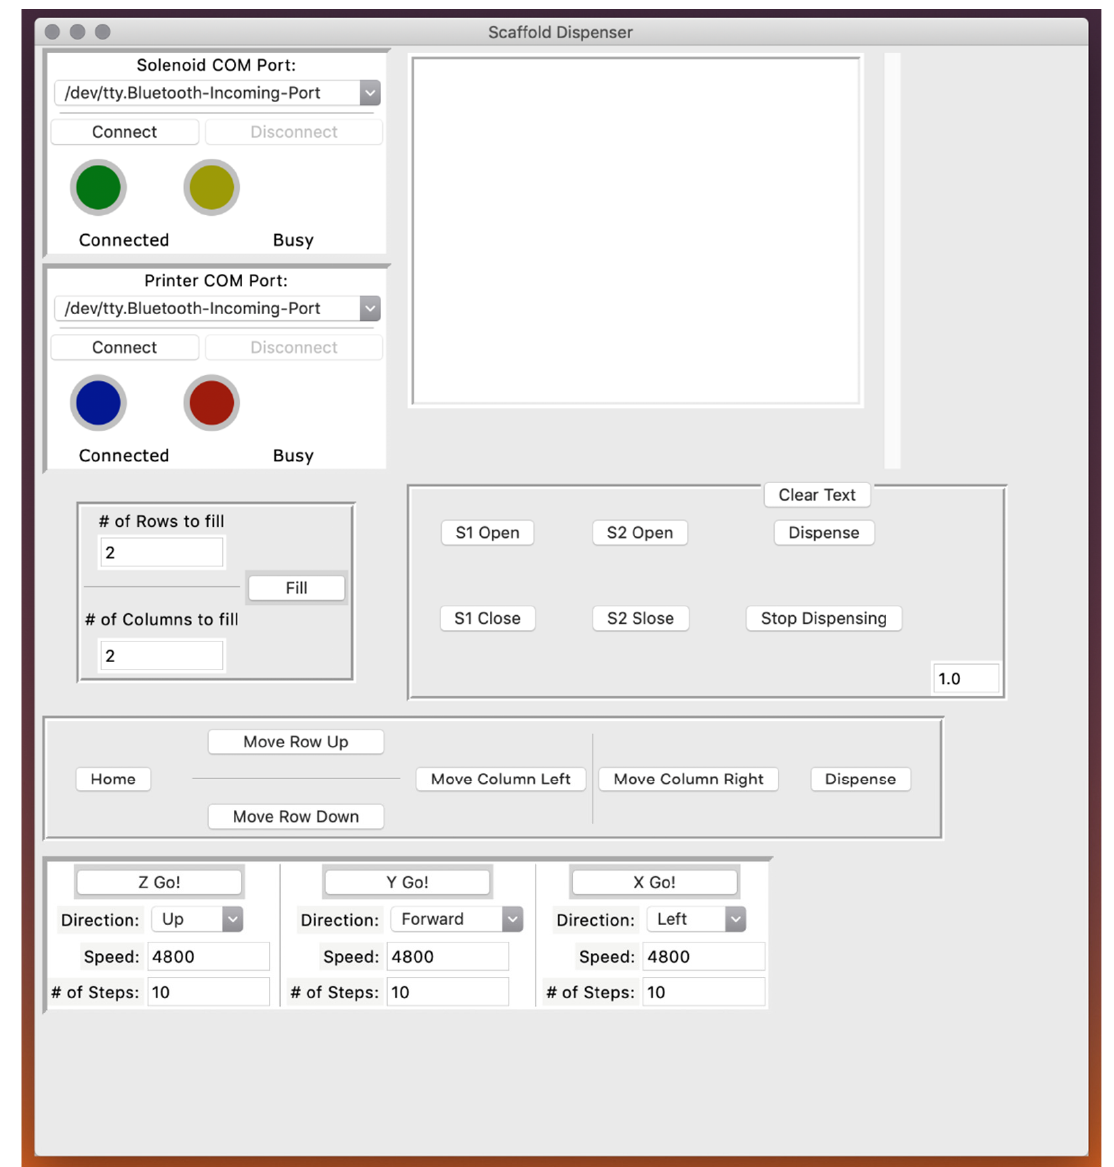
Figure 3. Graphical user interface. A screenshot of the scaffold dispensing control software.